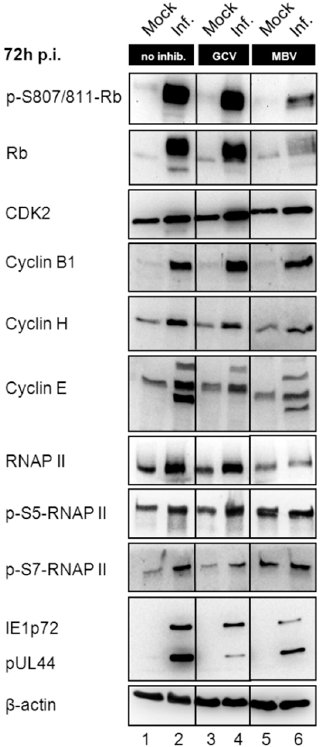
Figure 3. Western blot (Wb) detection of cyclin levels, as well as viral and cellular reference proteins, in mock and HCMV ‐ infected primary fibroblasts, using phospho ‐ specific antibodies. MBV is shown to exert a differential impact on the expression levels of several cellular and viral proteins. HFFs were infected with HCMV AD169 ‐ GFP (MOI 0.3) and MBV (30 μ M), reference compound ganciclovir (GCV; 20 μ M) or DMSO alone (infected; Inf.) was added immediately after infection. Cells were harvested 72 hours post ‐